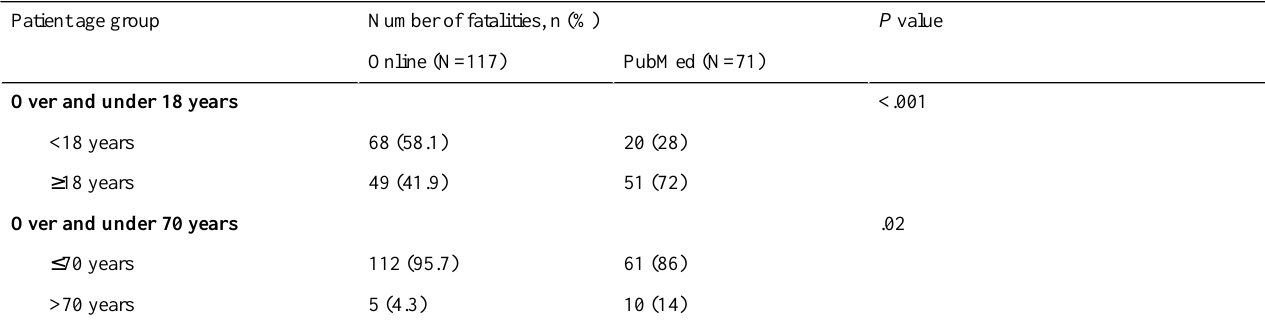
Table 6. Comparison of fatalities reported in online and PubMed publications with respect to the age of deceased patients.